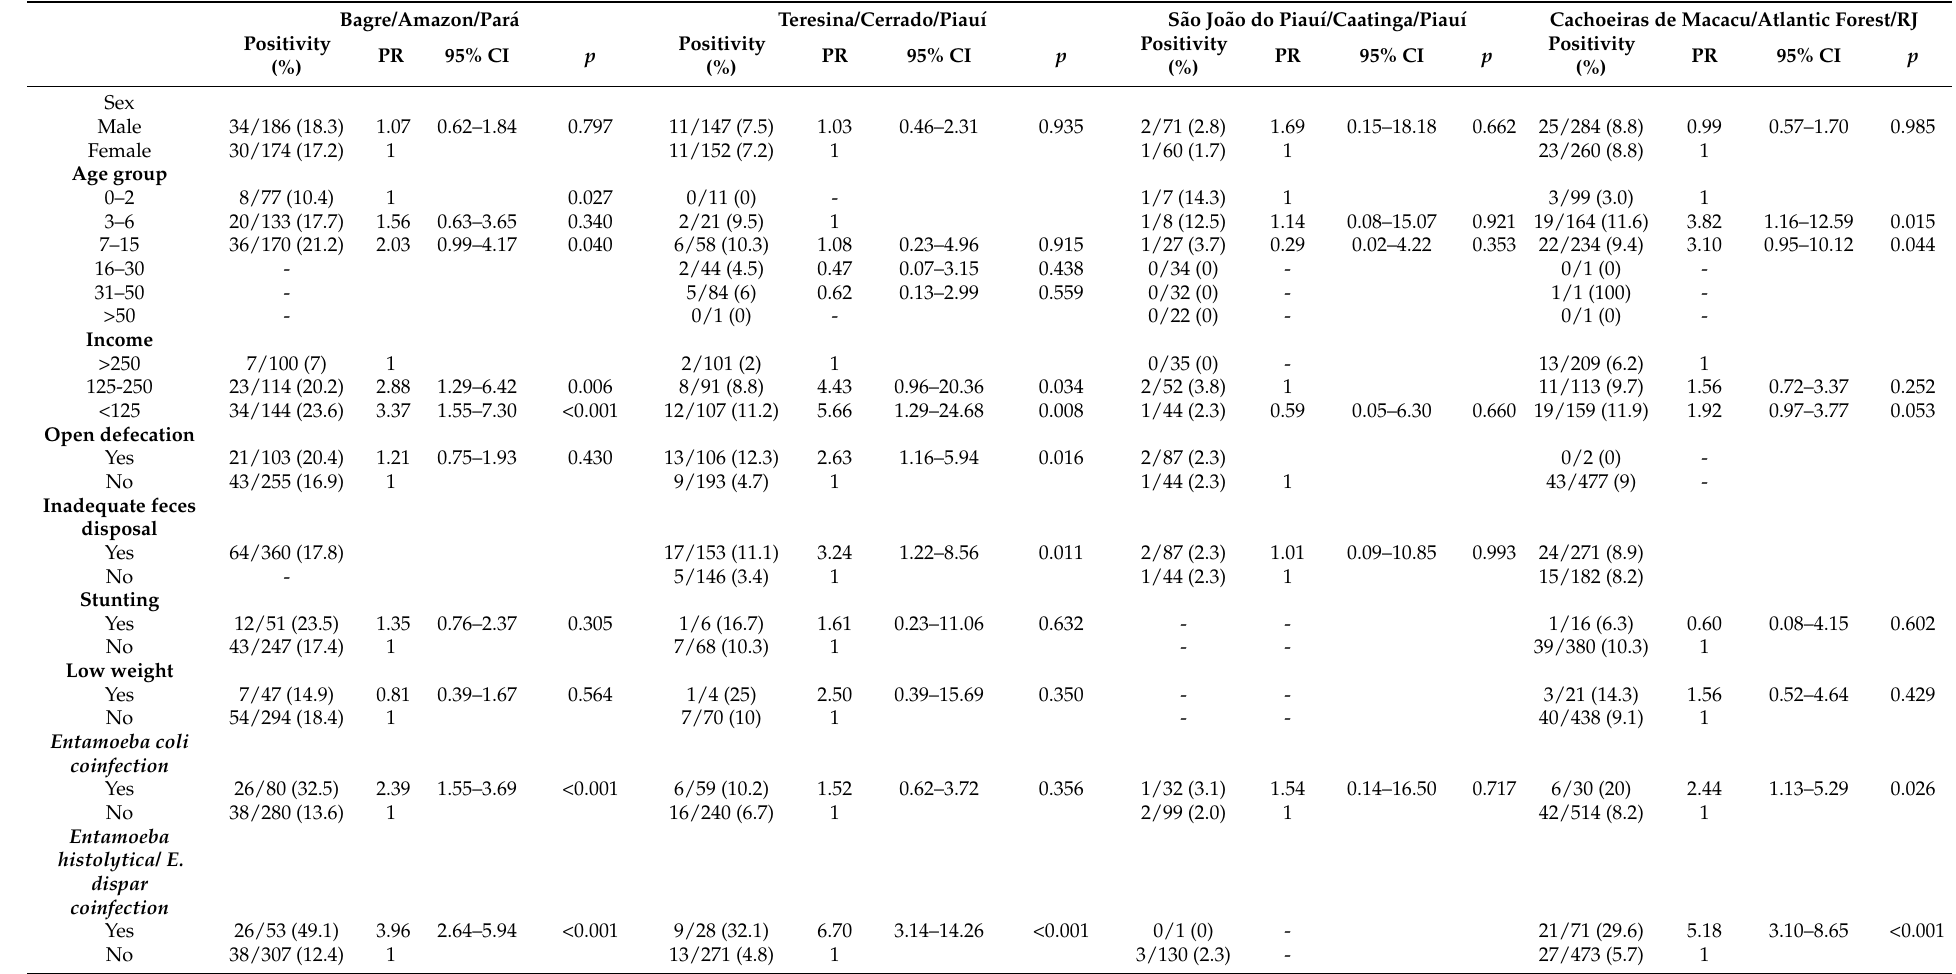
Table 3. Positivity rates in different groups defined by sociodemographic characteristics and the association of giardiasis with other intestinal protozoa ( Entamoeba histolytica/Entamoeba dispar or Entamoeba coli ) in different Brazilian biogeographic